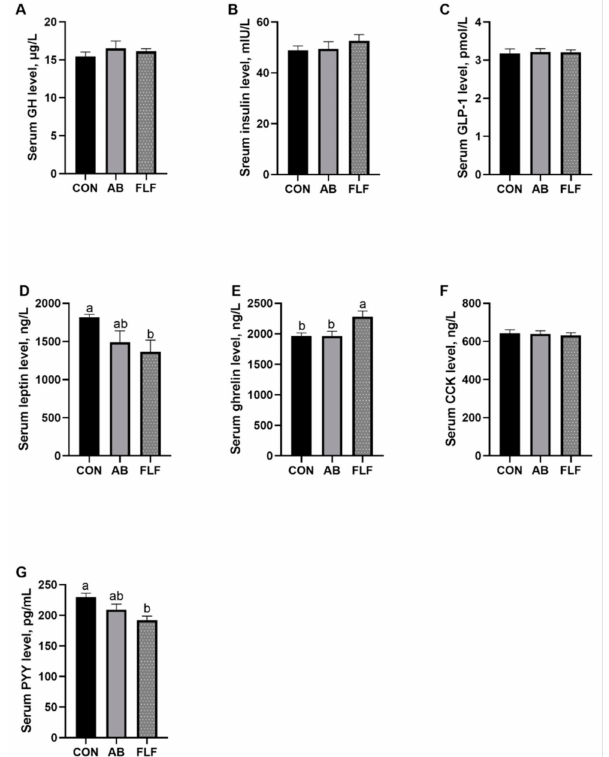
Figure 1. Effects of fermented liquid feeding on the serum hormone parameter of pigs. Values are means ± SEM, ( n = 6). CON: control group; AB: antibiotics group; FLF: fermented liquid feeding group. Serum GH level ( A ); Serum insulin level ( B ); Serum GLP-1 level ( C ); Serum leptin level ( D ); Serum ghrelin level ( E ); Serum CCK level ( F ); Serum PYY level ( G ). GH: growth hormone; GLP-1: